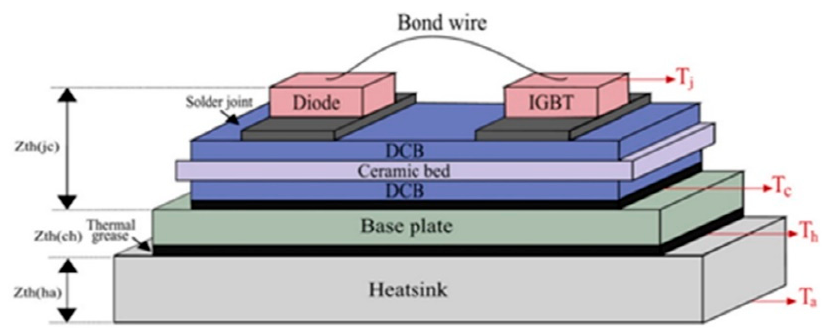
Figure 13. The standard multilayer arrangement of a power module [22].